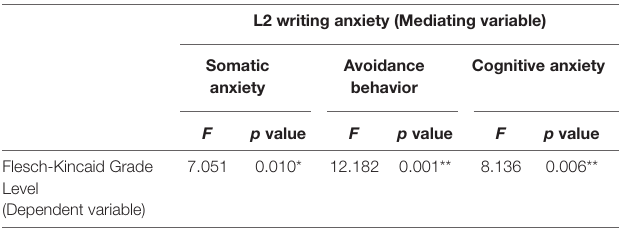
TABLE 2 | The impact of L2 writing anxiety on Flesch-Kincaid Grade Level: regression analysis.